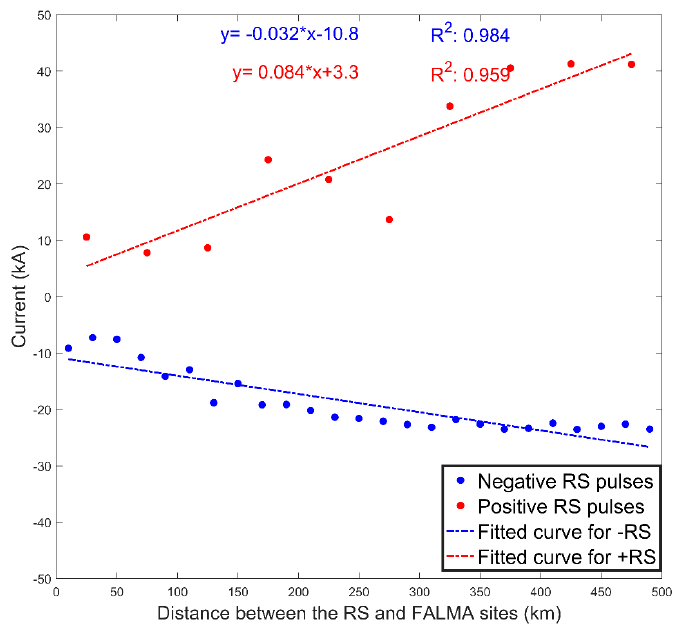
Figure 11. Scatterplots of the mean values for positive (red dots) and negative (blue dots) RS peak currents in different distance ranges. The fitted curves of RS peak currents by distance are represented by dashed lines with the equation and fitting goodness marked on the upper half.